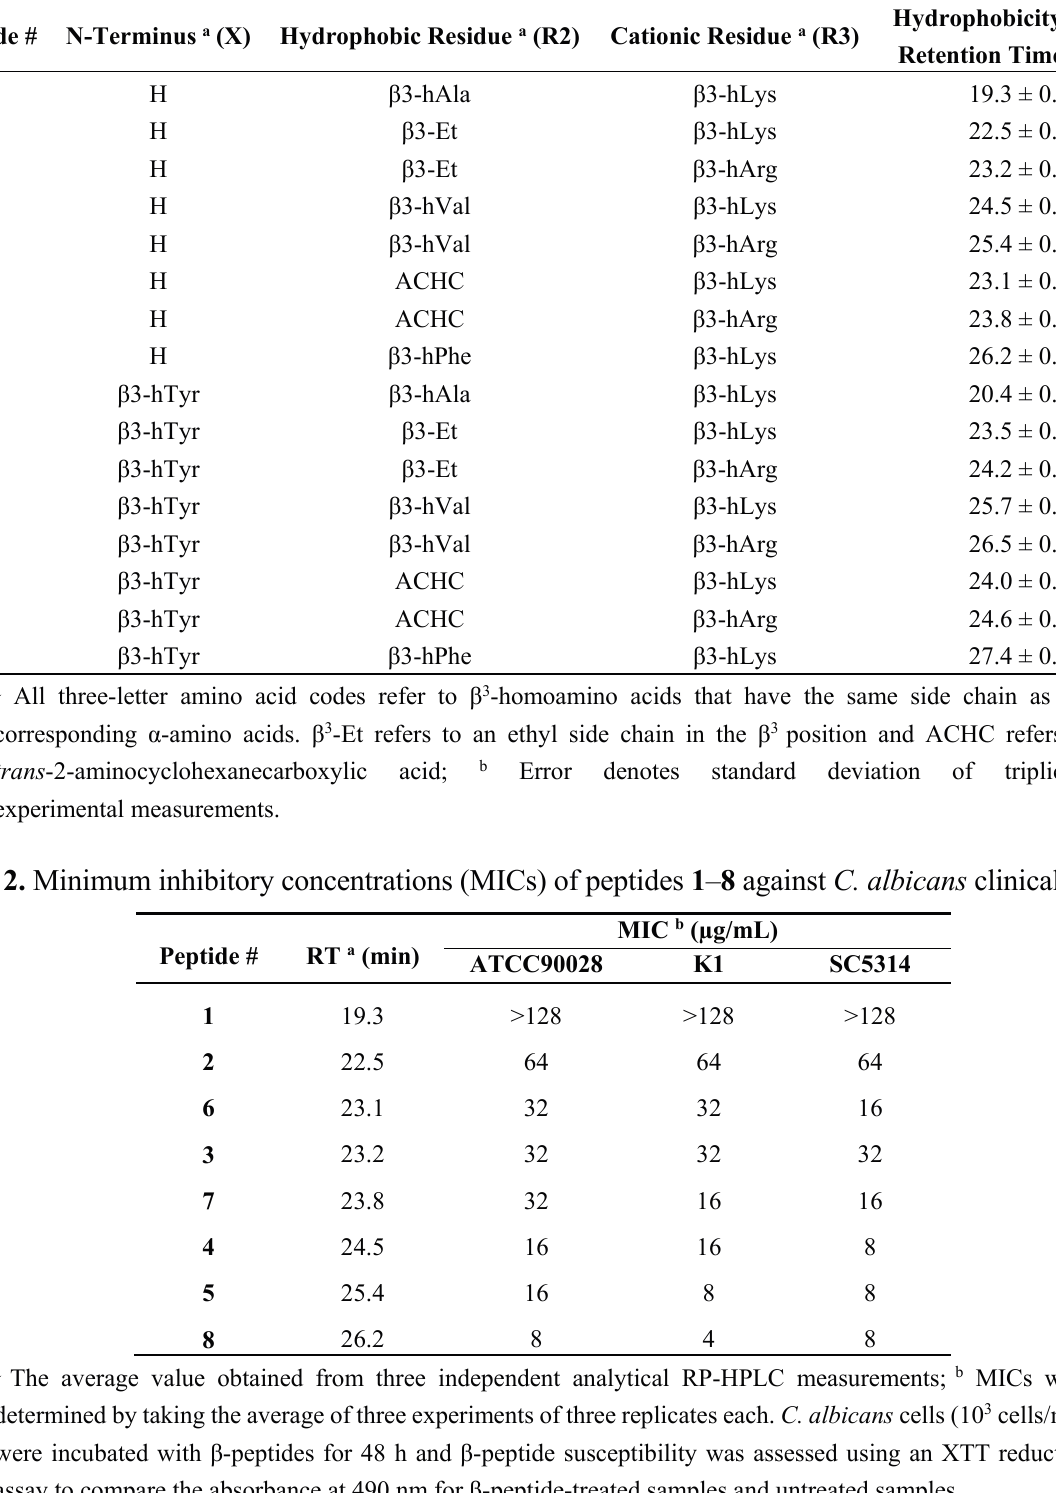
Table 1. Sequence and RP-HPLC retention times of 14-helical β -peptides, 1 – 16 , used in this study. Peptide #